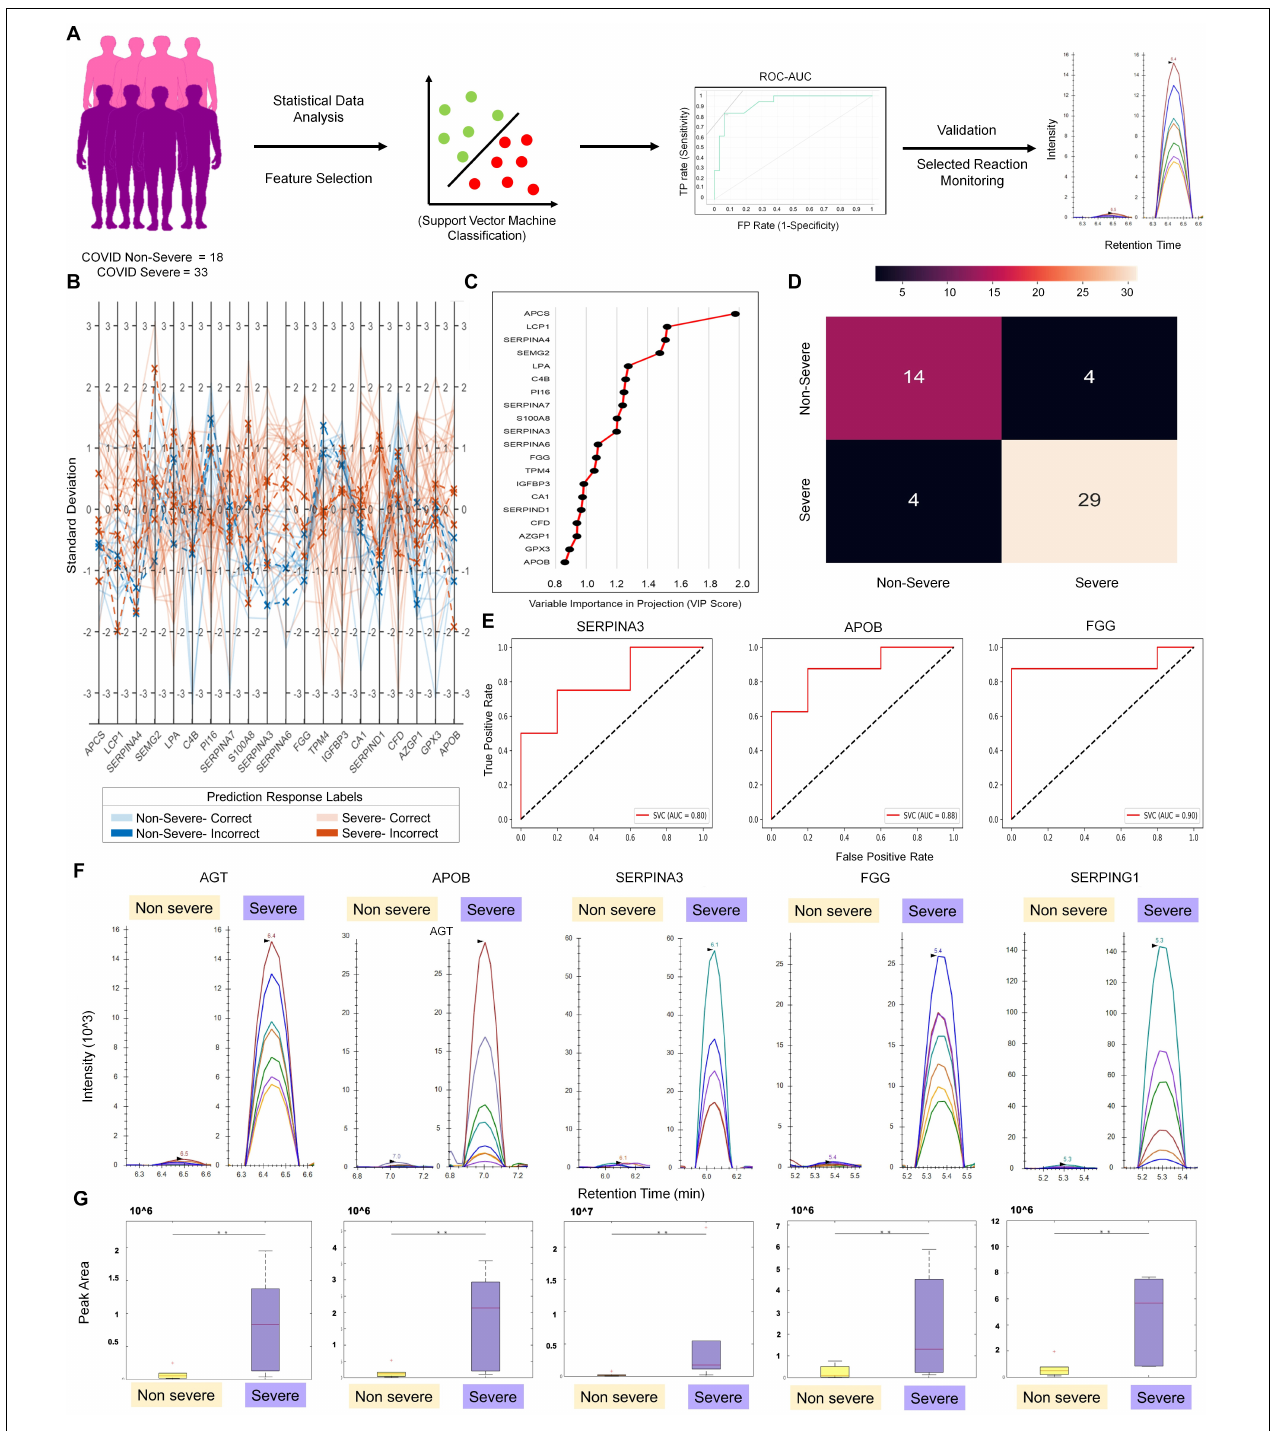
FIGURE 3 | Machine learning–based approach for identification of severity classifiers and validation of protein markers using MRM approach. (A) Demonstrates the schematic workflow of machine learning and MRM validation. (B) The parallel coordinate plot and prediction response labels. (C) Depicts the top 20 features and their variable importance in projection (VIP) scores in the X -axis. (D) The confusion matrix plotted from the model prediction. (E) Displays the ROC–AUC curve of SERPINA3, APOB, and FGG from the severity model prediction. (F) MRM analysis of proteins overexpressed in COVID-19 severe vs. COVID-19 non-severe patient samples, as identified in the LFQ analysis and machine learning approach. Peak shapes (as seen in Skyline) of representative peptides of proteins AGT, APOB, SERPINA3, FGG, and SERPING1, respectively. (G) Box plots showing the overexpression of same proteins in severe as compared with non-severe samples in terms of the MRM peak areas ( t -test, ** p < 0.05; fold change > 3 at a CI of 95–99% determined by Skyline).